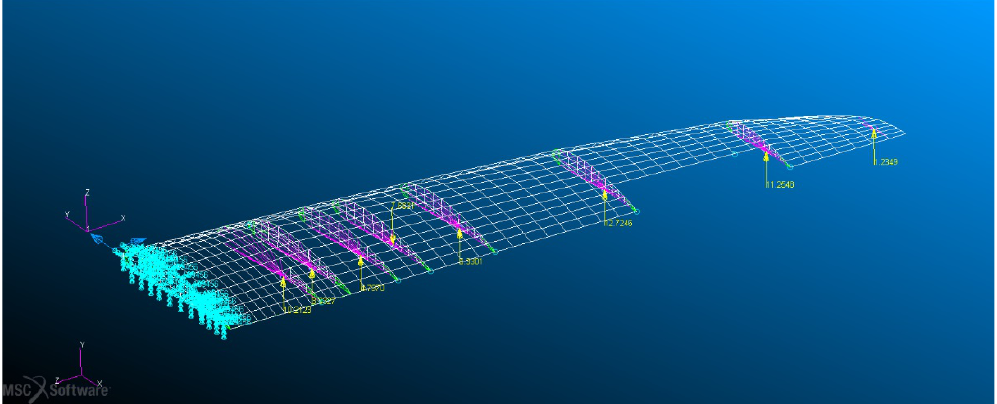
Figure 5. Half-wing boundary and loading conditions (concentrated forces have both y -axis and a z -axis component, then are applied to each rib by means of rigid connections and correspond to the aerodynamic loads experienced during a straight-and-level flight).